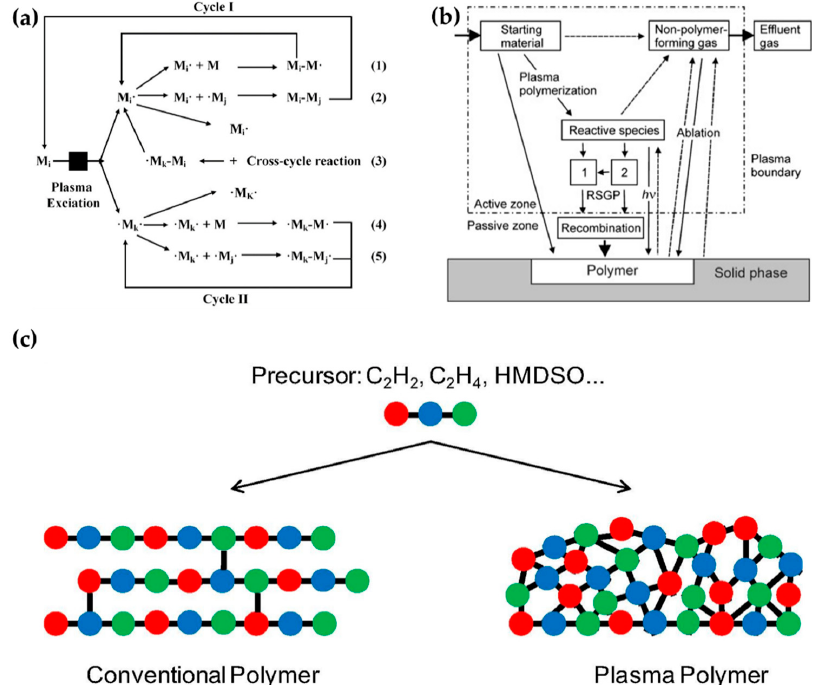
Figure 14. ( a ) Mechanisms of plasma polymerization [113]. ( b ) A scheme of a general plasma polymerization system [114]. ( c ) Comparison of a conventional polymer (left) and plasma polymer (right), derived from equivalent monomers [116].